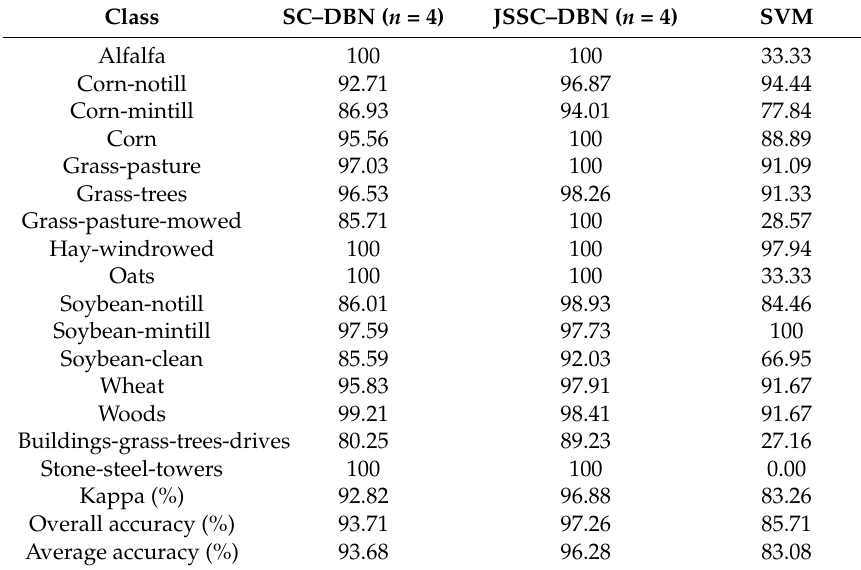
Table 5. Classification result on Indian Pines.